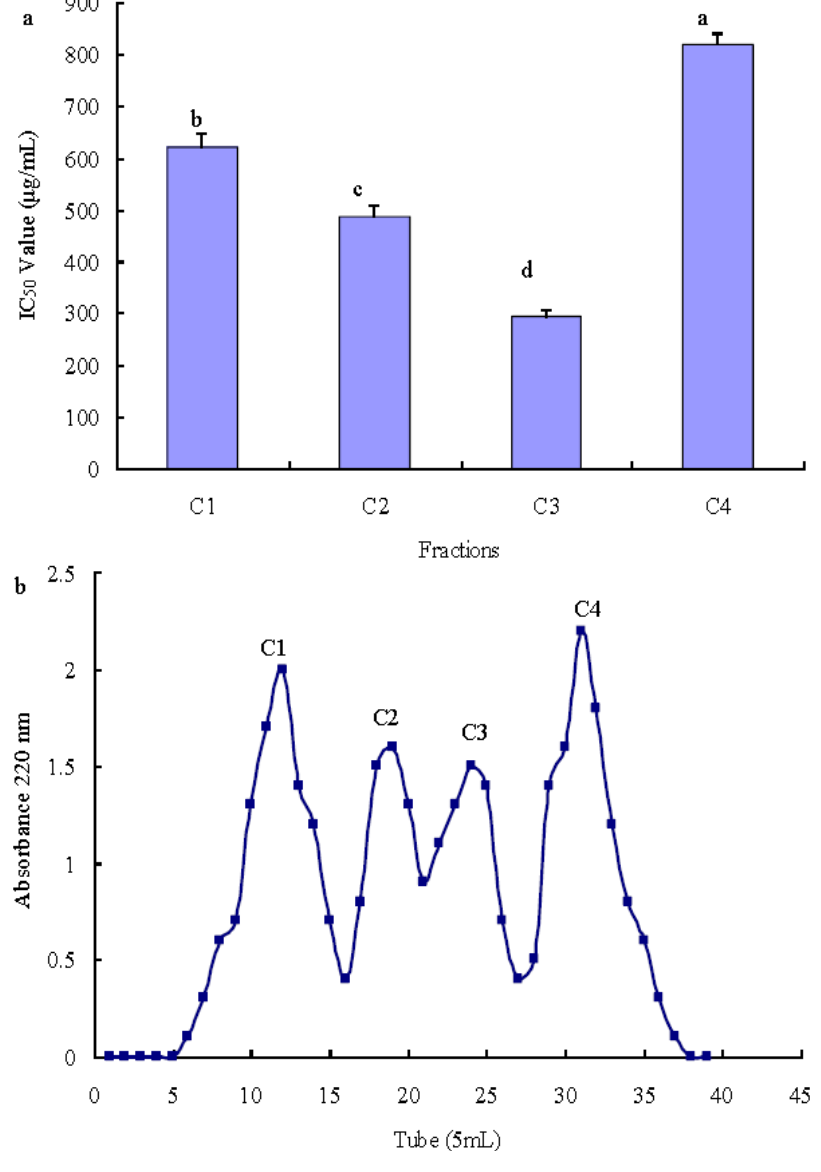
Figure 3. Sephadex G-25 gel chromatography of Fraction C ( a ) and the IC ( μ g/mL) of each fraction was measured by hydroxyl radical scavenging activity ( b ). Different letters indicate significant differences ( p <